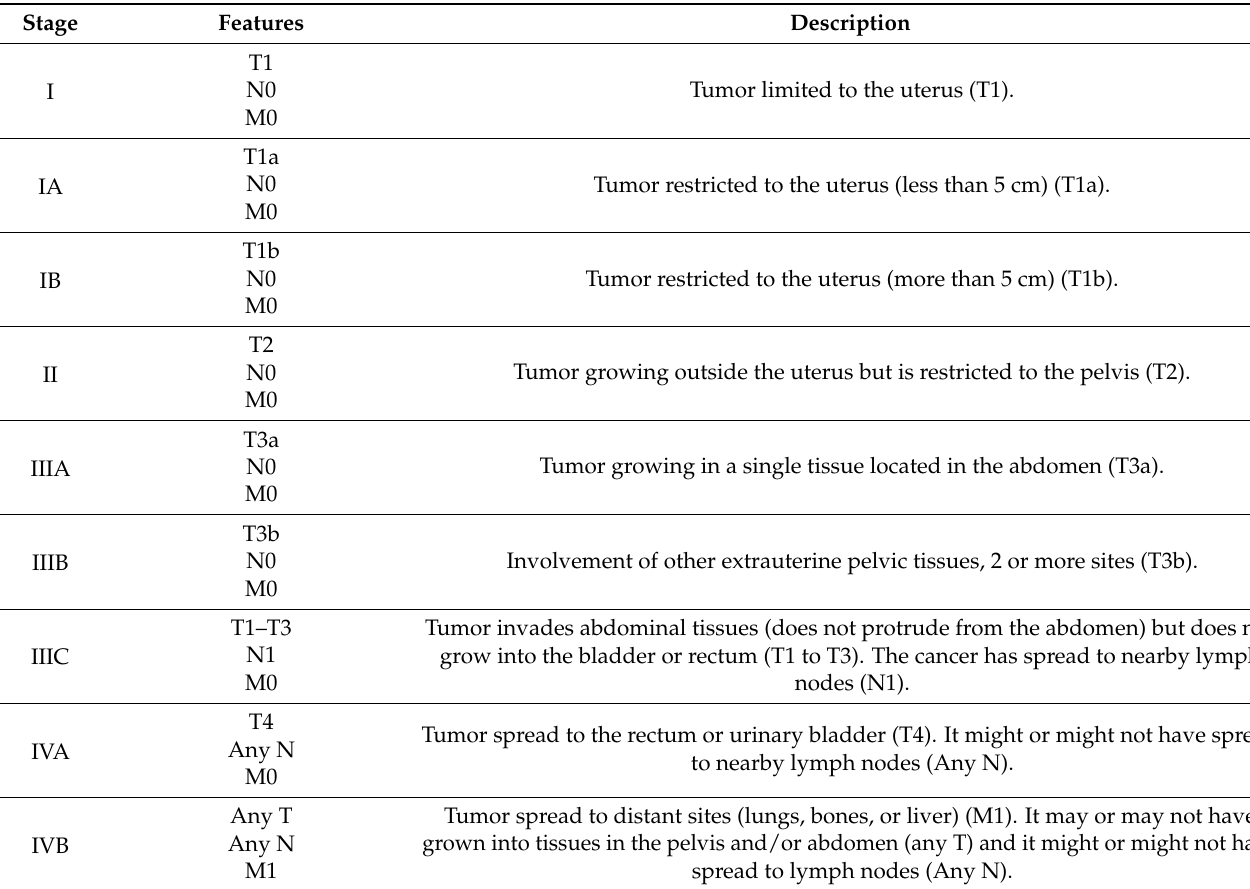
1 FIGO: International Federation of Gynecology and Obstetrics classification (2009). 2 AJCC: American Joint Committee on Cancer TNM staging system